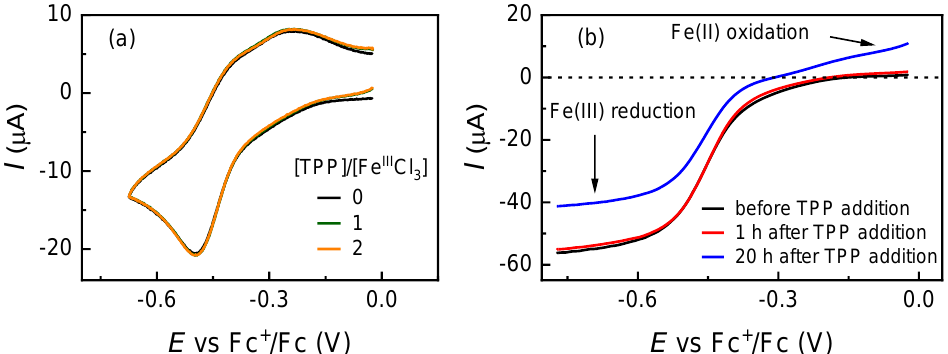
Figure 5. Voltammetry of 1.16 mM FeCl 3 in DMF + 0.1 M Et 4 NBF 4 recorded on a GC electrode at T = 25 °C; ( a ) CV recorded at v = 0.2 V/s before and after addition of TPP; ( b ) linear sweep voltammetry on a rotating disc electrode at ω = 2000 rpm and v = 0.005 V/s, recorded before and after addition of a 2-fold excess of TPP.